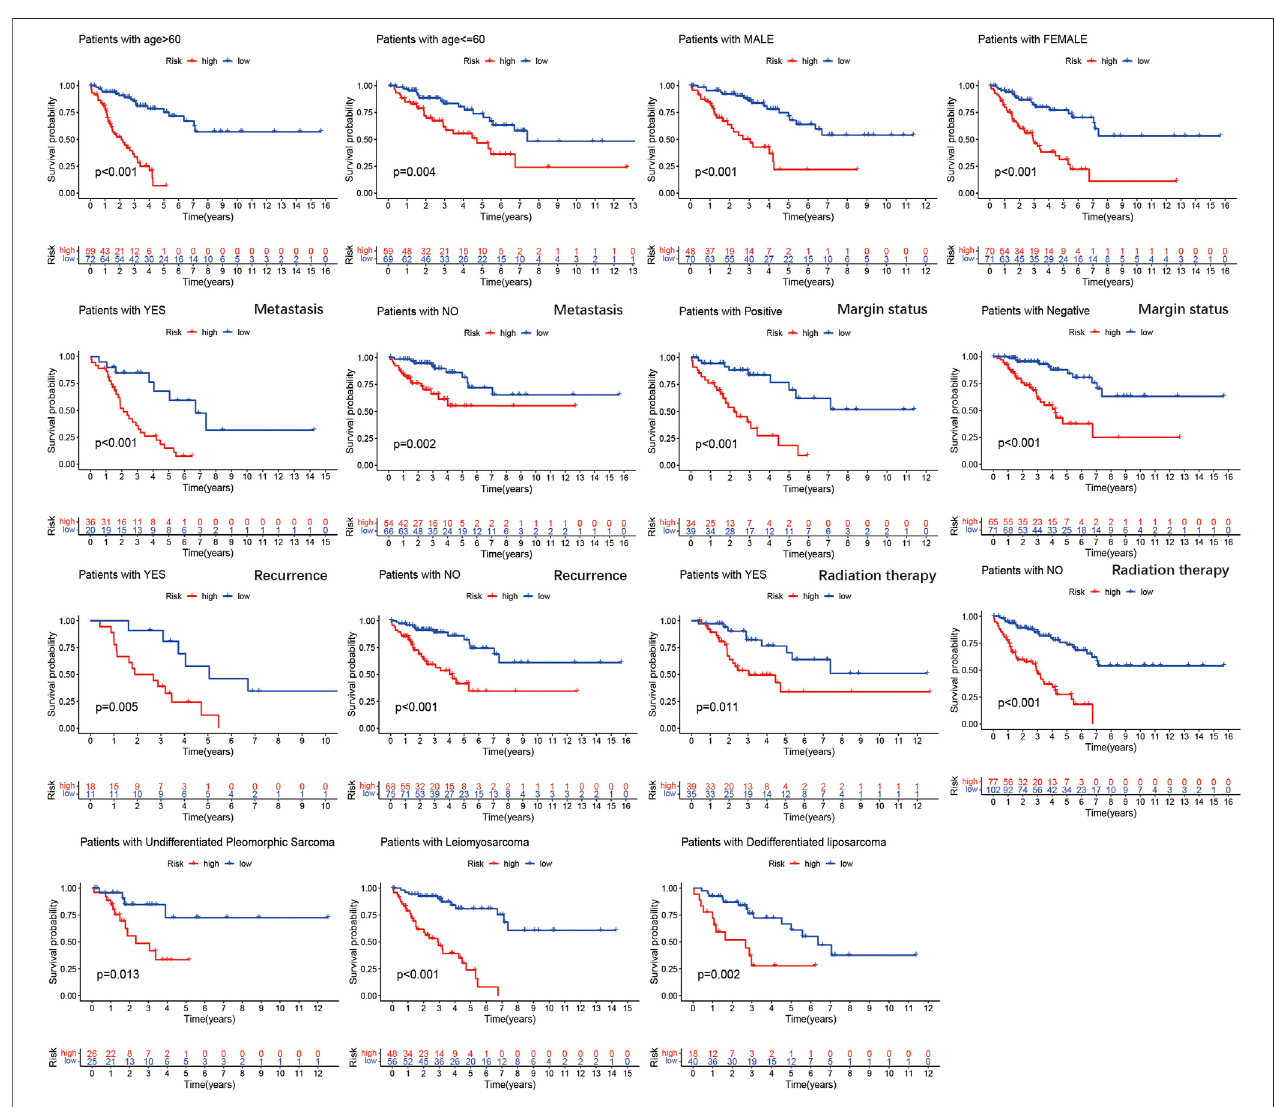
FIGURE 9 | Kaplan – Meier analysis of the association between the risk signature and overall survival in subgroups based on age, gender, con fi rmed recurrence, con fi rmed metastasis, con fi rmed radiation therapy, margin status, and histological type.